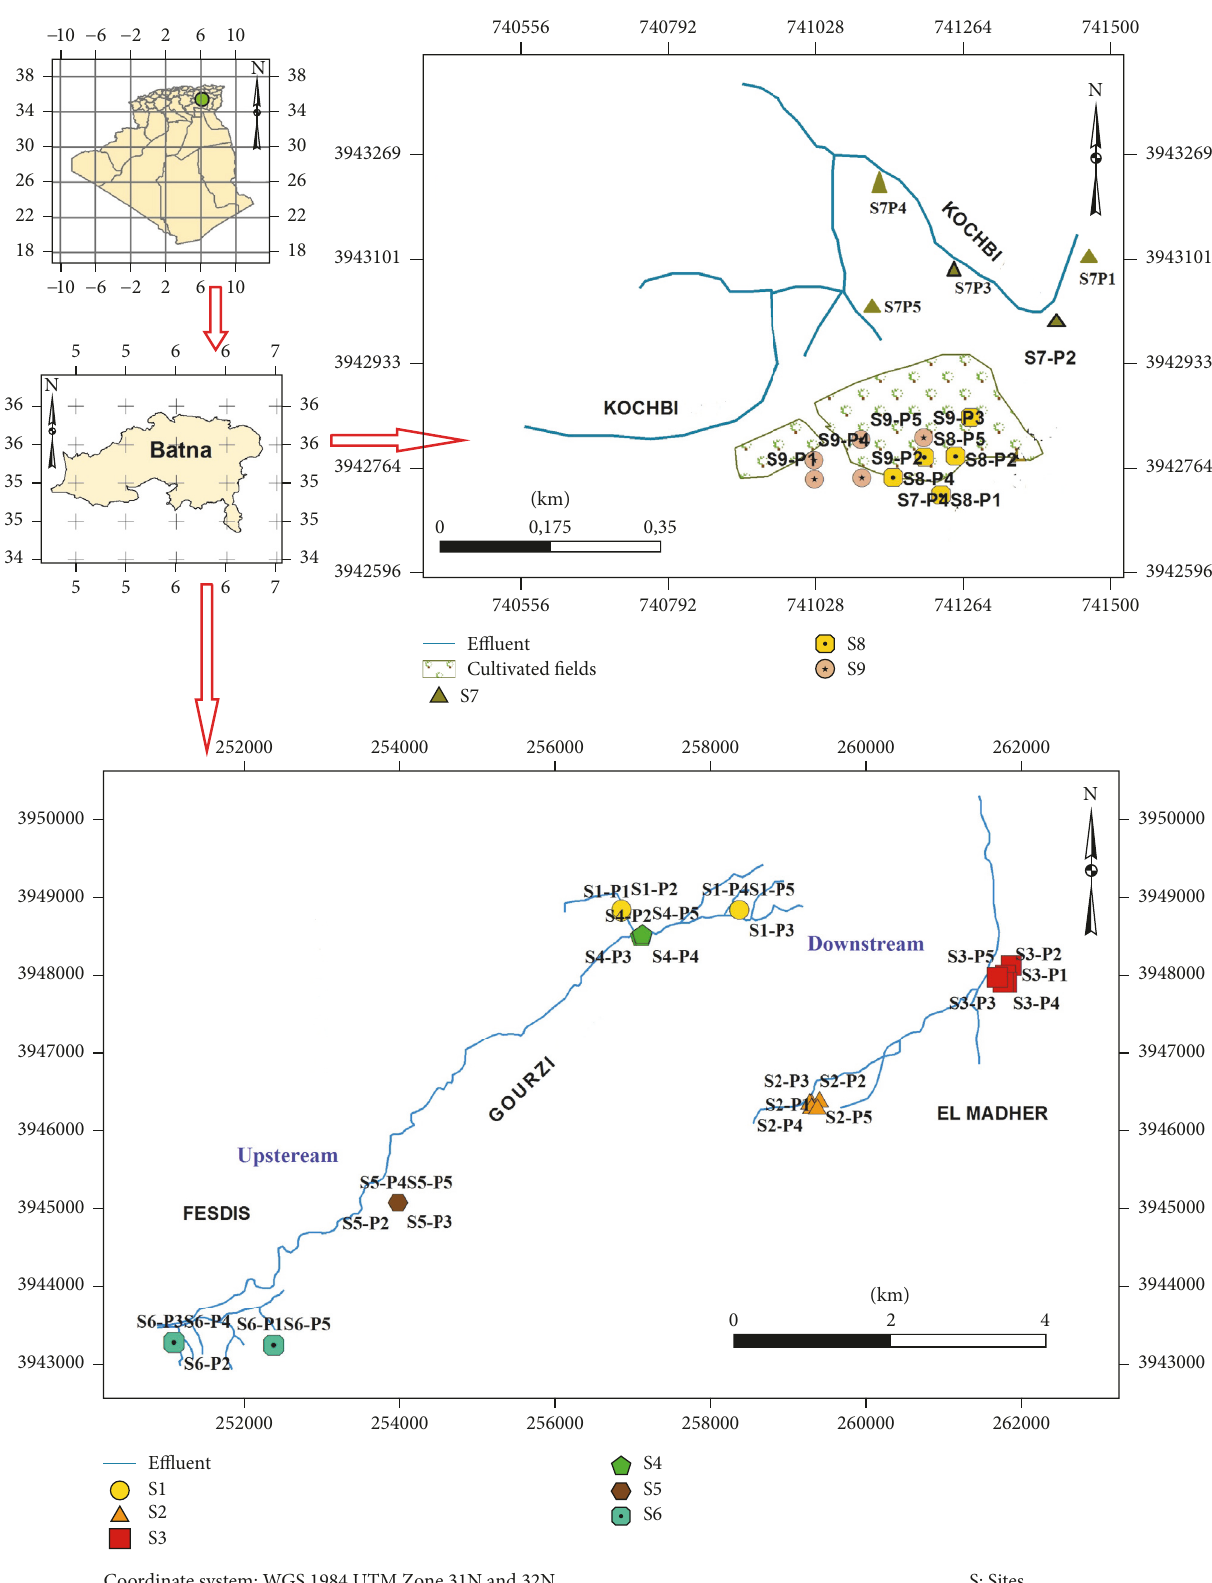
Figure 1: Maps of localisation of study area and sampling sites at edges of El Gourzi and El Kochbi